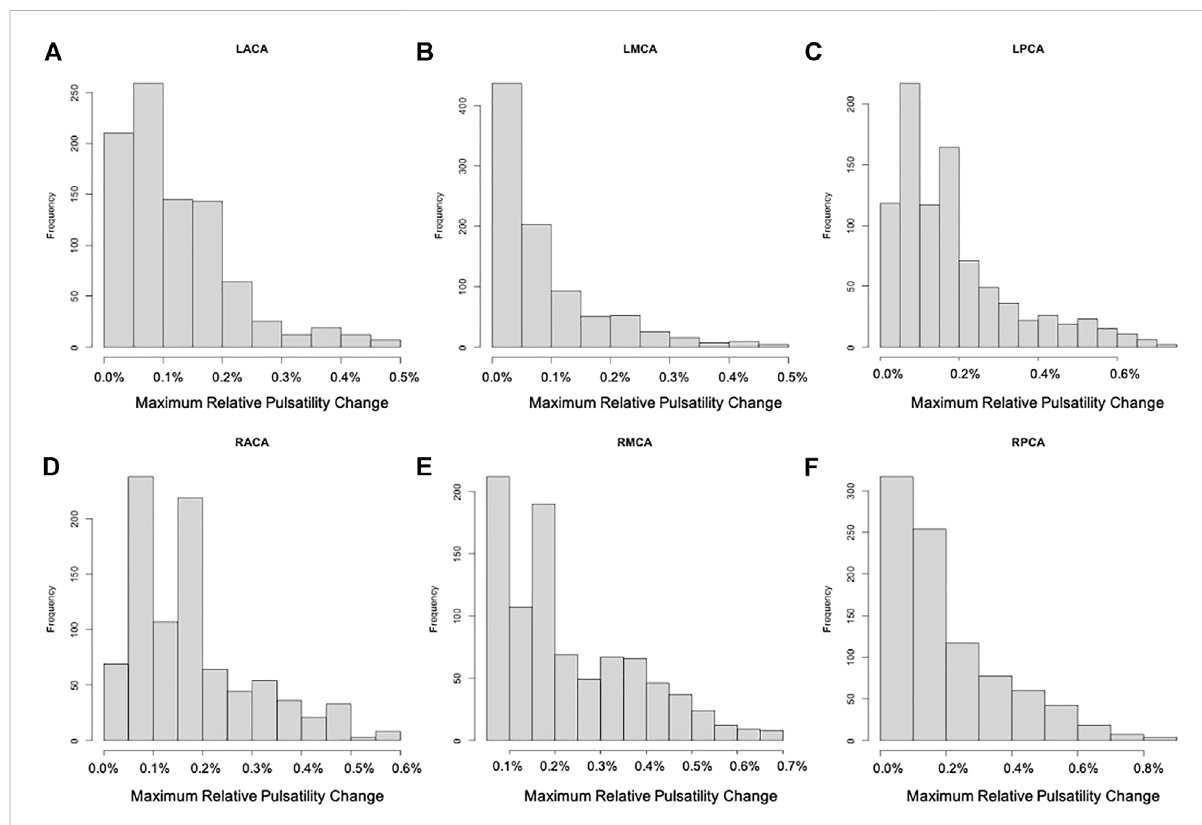
FIGURE 4 Histograms showing the frequency of maximum relative change of pulsatility for each of the six cerebral arterial trees obtained for thedifferent scenarios considered: (A) LACA, (B) LMCA, (C) LPCA, (D) RACA, (E) RMCA, (F) RPCA. These histograms show that the largest change was approximately 0.85% (maximum change occurred in the posterior cerebral artery